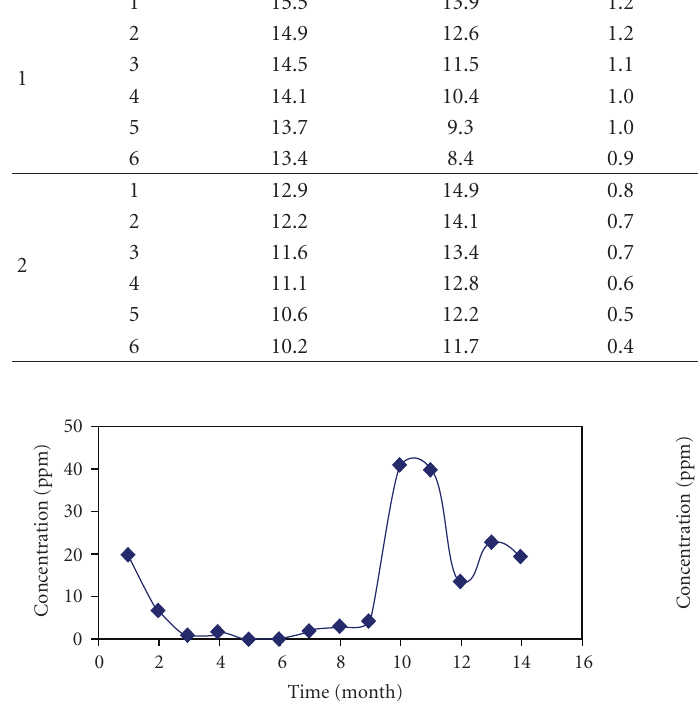
Figure 4: SO 4 ion concentration in the permeate.